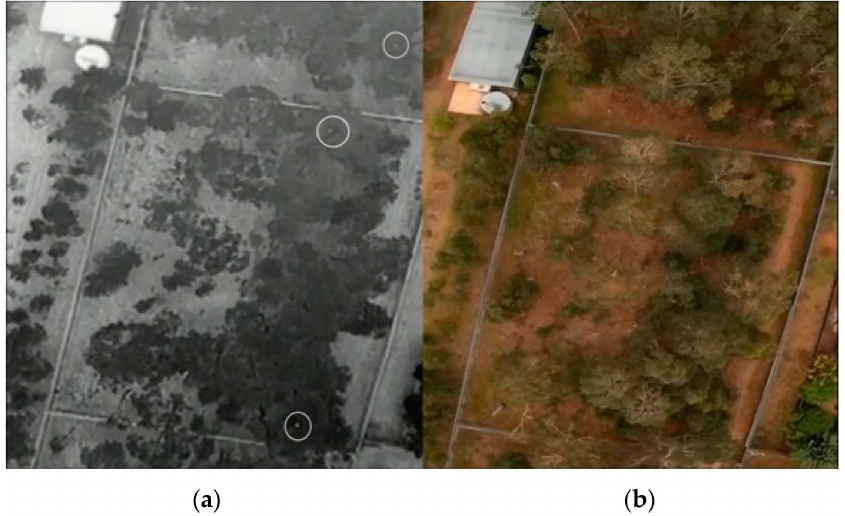
Figure 15. ( a ) Thermal image ( b ) digital RB6 capture at 80